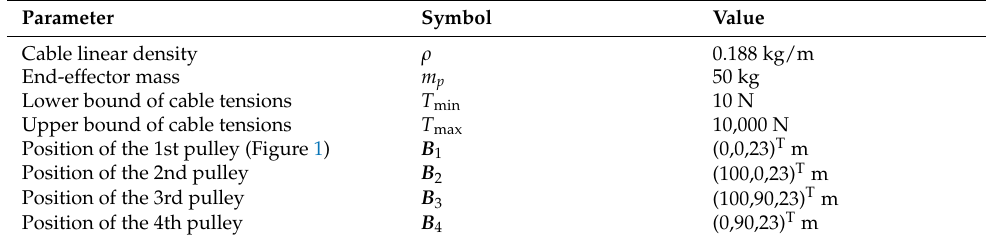
Figure 2. The investigated camera robot. Table 1. Model